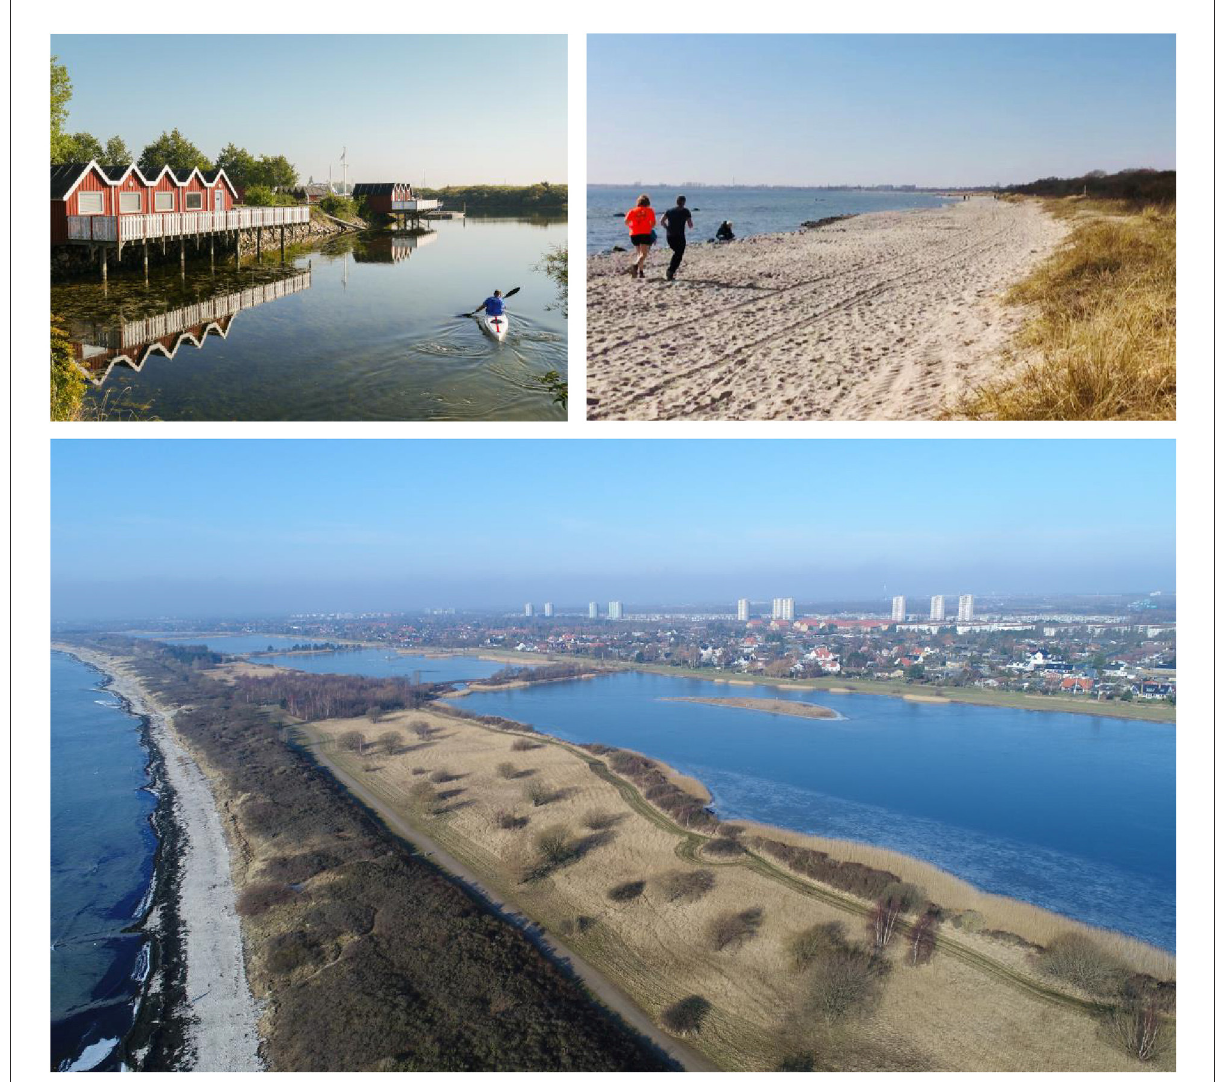
FIGURE4 Køge Bay Beach Park, barrier islands for coastal protection (Top left) Marina, boathouses at lagoon (Anna Lund). (Top right) Recreational beach (Anna Lund). (Bottom) Barrier Island seen towards the south with urban settlement in the background (Drone image by Henrik Hedelund, Ishøj